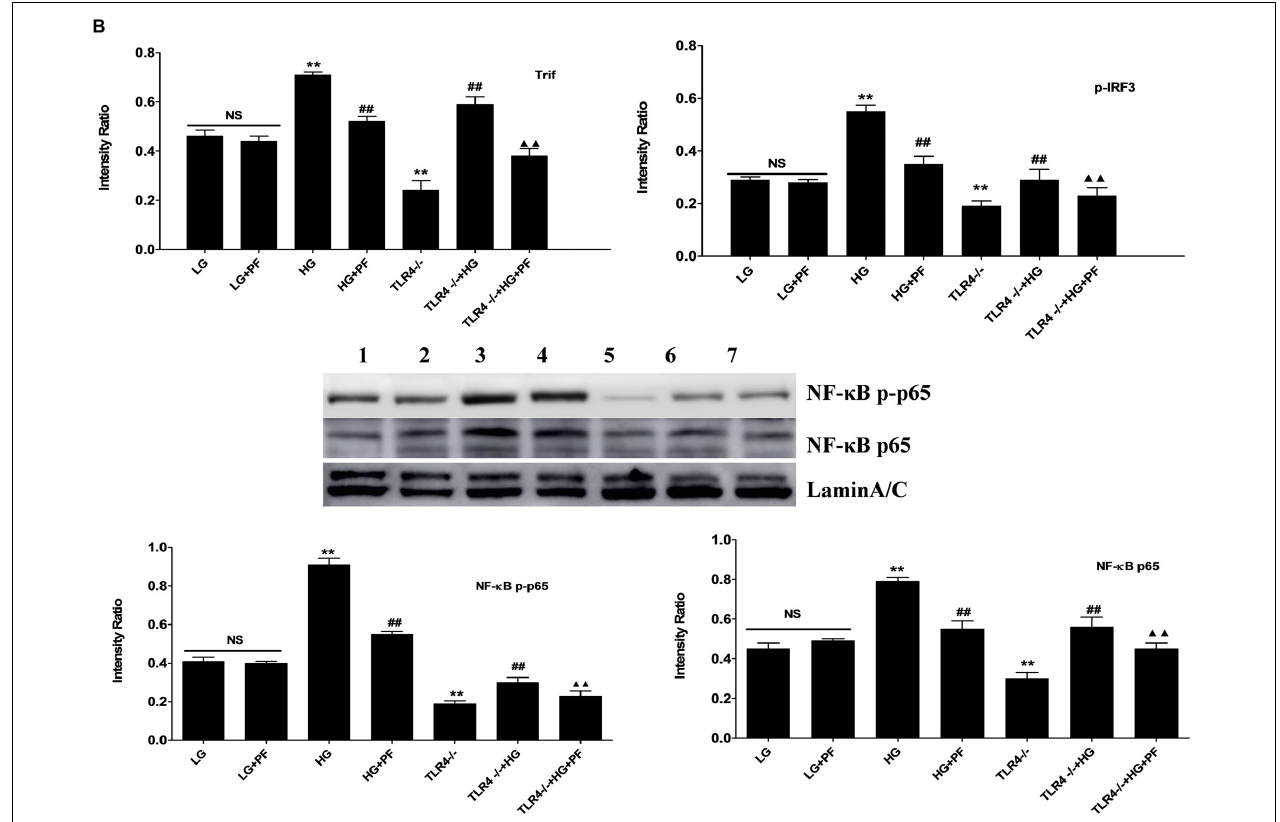
FIGURE 7 | PF inhibited the activation of TLR4 and its downstream signaling pathway in HG-induced BMDMs. (A) Densitometric analyses of the protein levels of TLR4, MyD88, p-IRAK1, Trif, p-IRF3 and IRF3 in HG-treated BMDMs. (B) Densitometric analyses of the protein levels of NF- κ B p-p65, and NF- κ B p65 in HG-treated BMDMs. All data were normalized to the β -actin level and are expressed as the mean ± SD from at least three independent experiments. NS: not significant; ∗ P < 0.05 and ∗∗ P < 0.01 vs. the LG group; # p < 0.05 and ## p < 0.01 vs. the HG group; (cid:78) P < 0.05 and (cid:78)(cid:78) P < 0.01 vs. the TLR4-/-+HG group. Lanes: 1, LG; 2, LG+PF; 3, HG; 4, HG+PF; 5, TLR4-/-; 6, TLR4-/-+HG; and 7,